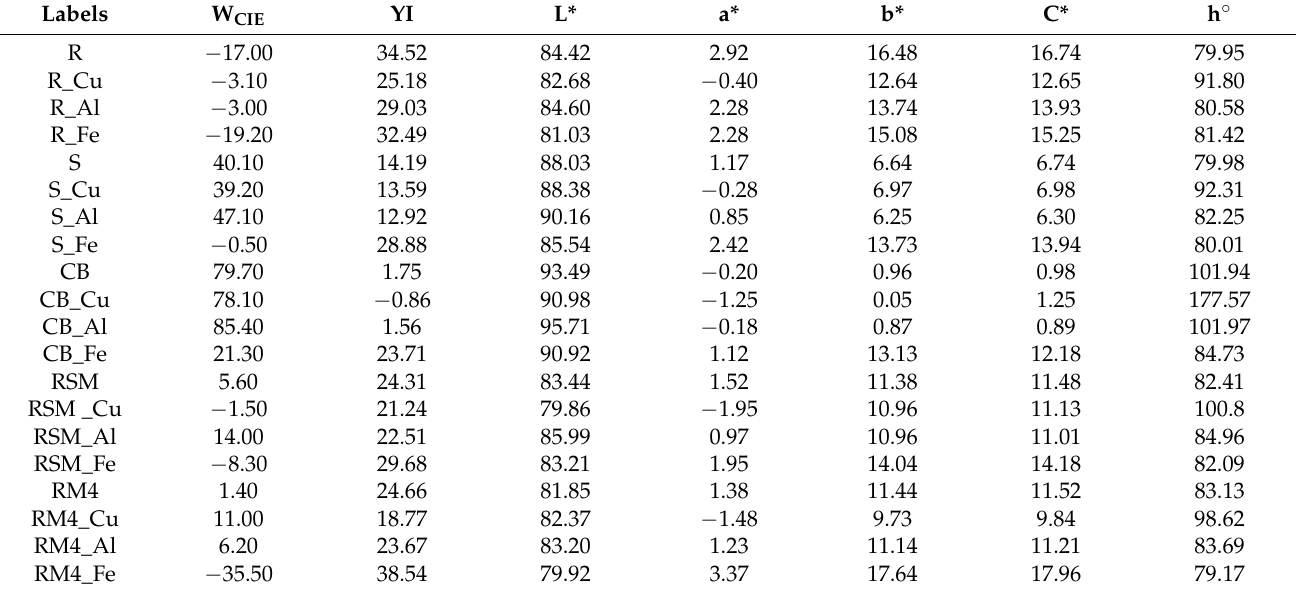
Table 3. Whiteness, yellowness index and spectral characteristics of pre-treatment and mordanted